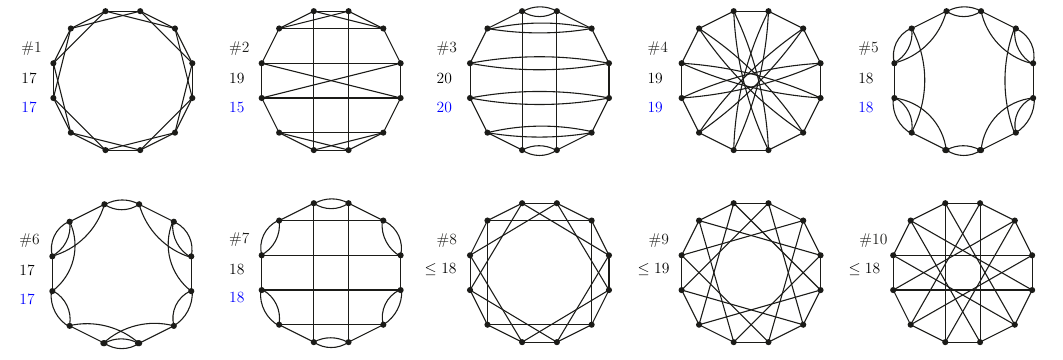
Figure 10 . A family of polygon diagrams numbers refer to the power of N in the O ( N ) model.